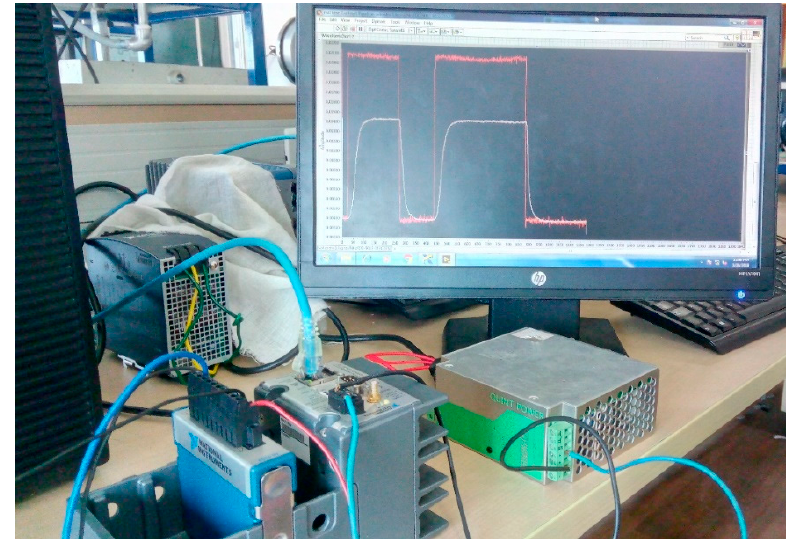
Figure 4. cRIO with NI 9203 connected to the computer.